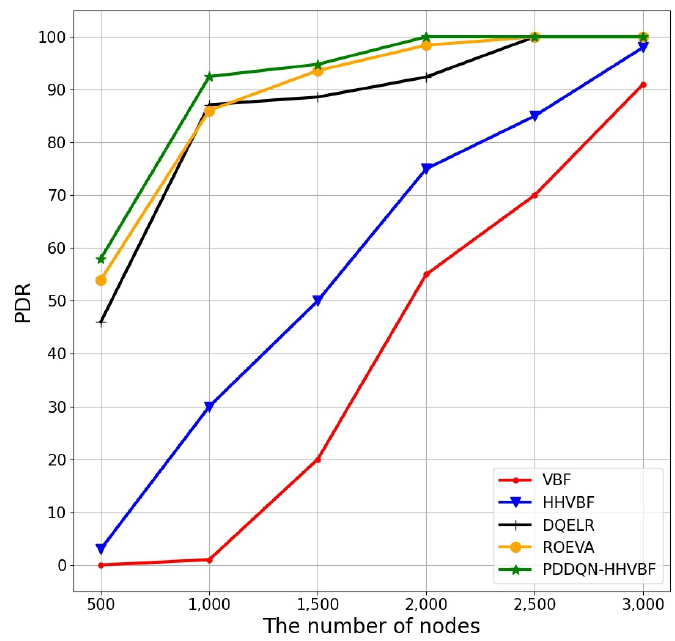
Figure 16. The PDR of VBF, HHVBF, DQELR, ROEVA, and PDDQN-HHVBF protocol in different number of network